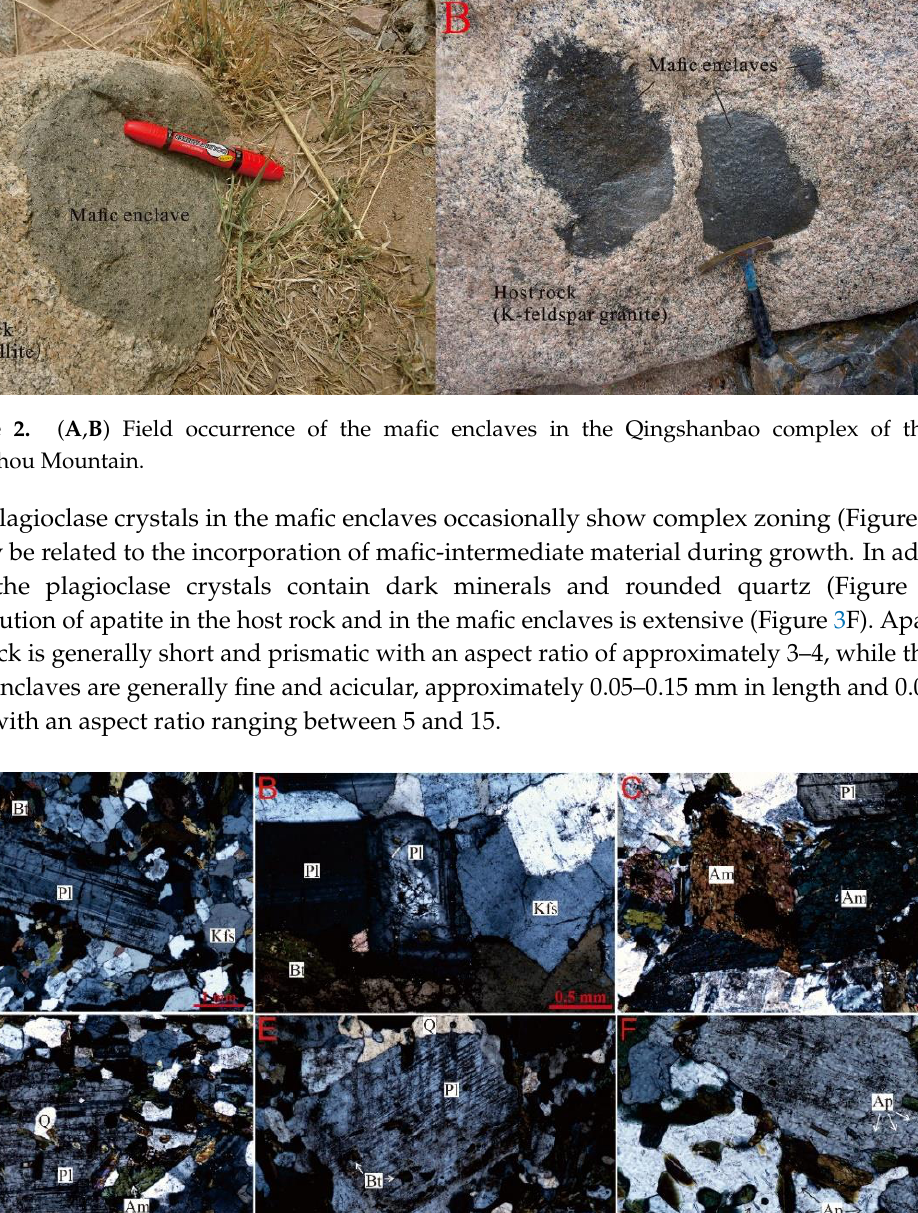
Figure 3. Photo-micrographs showing the mineralogy and textures of the mafic enclaves. ( A ) Euhedral tabular plagioclase in the dark color pack with hypautomorphic granular potassium feldspar and biotite. ( B ) Complex zoning in a plagioclase crystal. ( C ) Highly rhombohedral hornblende crystal and zoned plagioclase crystal. ( D ) Plagioclase enwrapped by rounded quartz. ( E ) Biotite inclusion in a plagioclase crystal that shows a dissolution texture and a scalloped edge. ( F ) Elongated acicular apatite. Key: Pl — Plagioclase; Am — Amphibole; Kfs — K-feldspar; Bt — Biotite; Q — Quartz; Ap — Apatite.